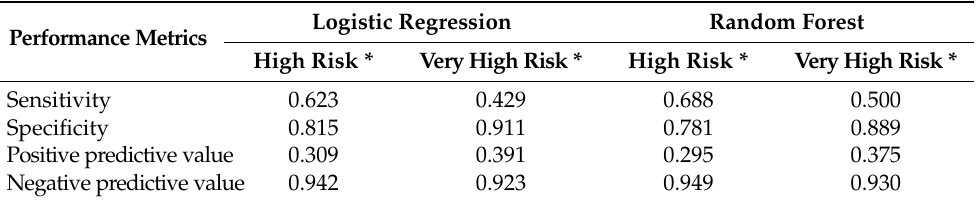
Table 5. Further evaluation criteria for the predictive models based on the core list scenario. Logistic Regression Random Forest Performance Metrics High Risk * Very High Risk * High Risk * Very High Risk * Sensitivity 0.623 0.429 0.688 0.500 Specificity